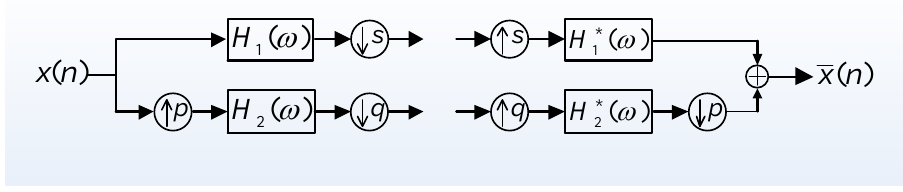
Figure 3. Two-channel filter banks of rational-dilation wavelet transformation (RADWT).